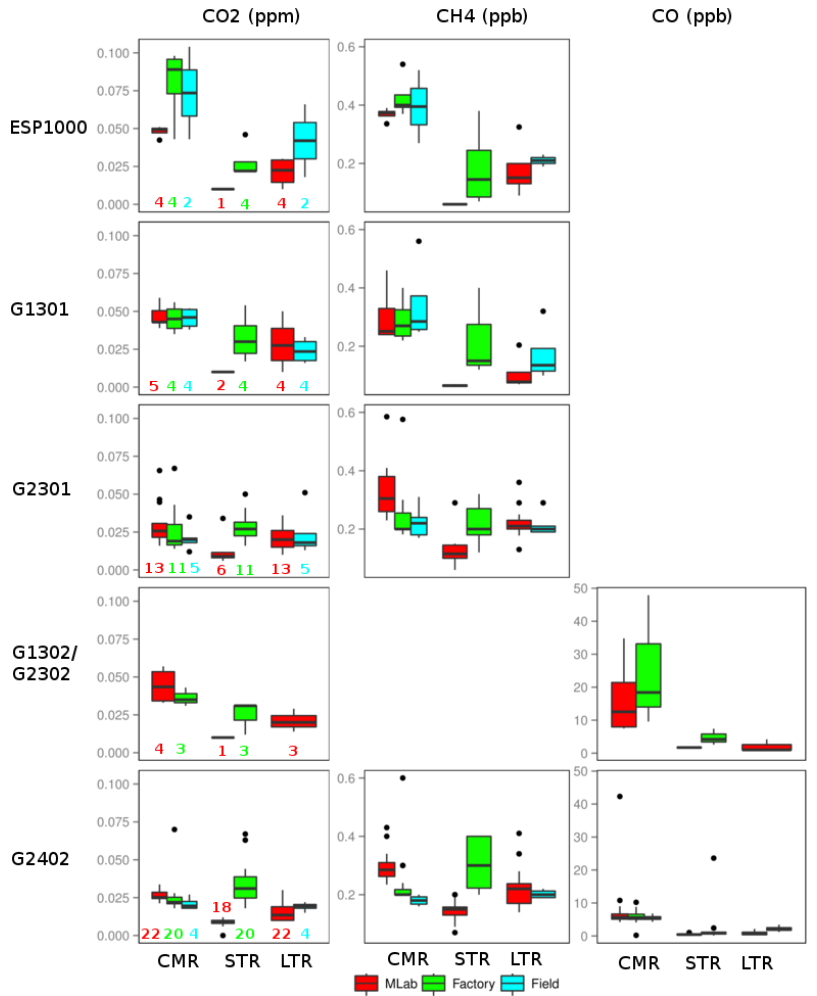
Figure 6. Whisker boxplots summarizing the CMR, STR and LTR tests for CO 2 (first column), CH 4 (second column) and CO (third column) by models. The mobile instruments are grouped with their main model. G1302 and G2302 are grouped together. The middle horizontal shows the median, the limits of the box the 25th and 75th quartiles, and the end of the whiskers the lowest datum still within 1.5 interquartile range (IQR – difference between the first and third quartiles) of the lower quartile, and the highest datum still within 1.5 IQR of the upper quartile. The numbers under the boxplots in the CO 2 column indicate the number of instruments tested in each